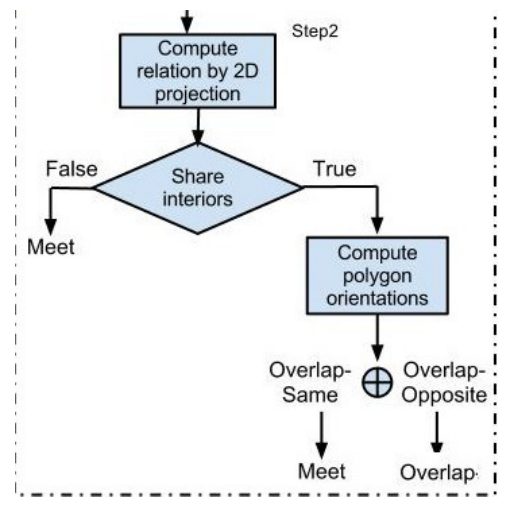
Figure 8: Extend step 2 of figure 6 to check the orientation of two overlapping polygons.